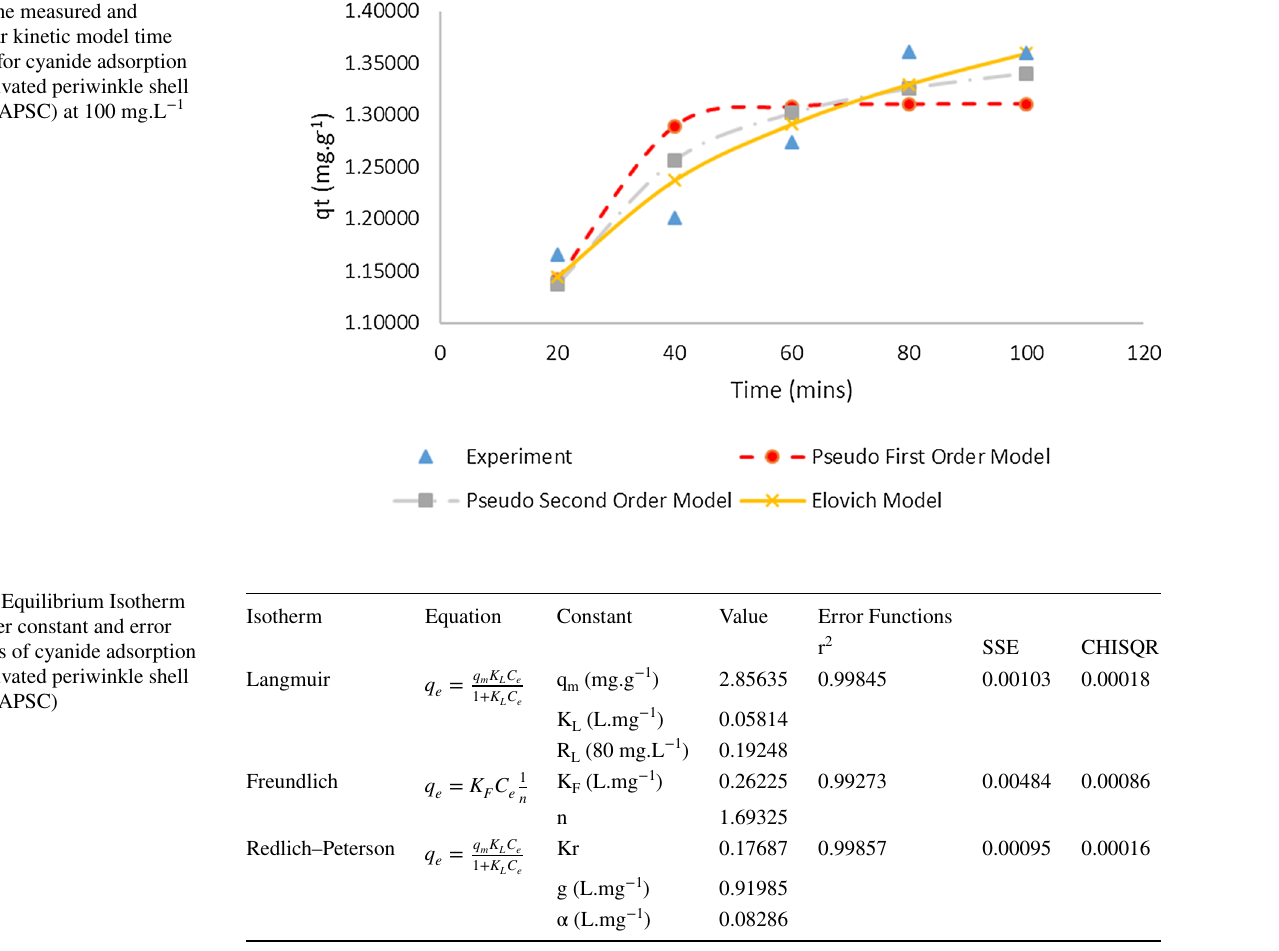
Fig.6 The measured and nonlinear kinetic model time profiles for cyanide adsorption